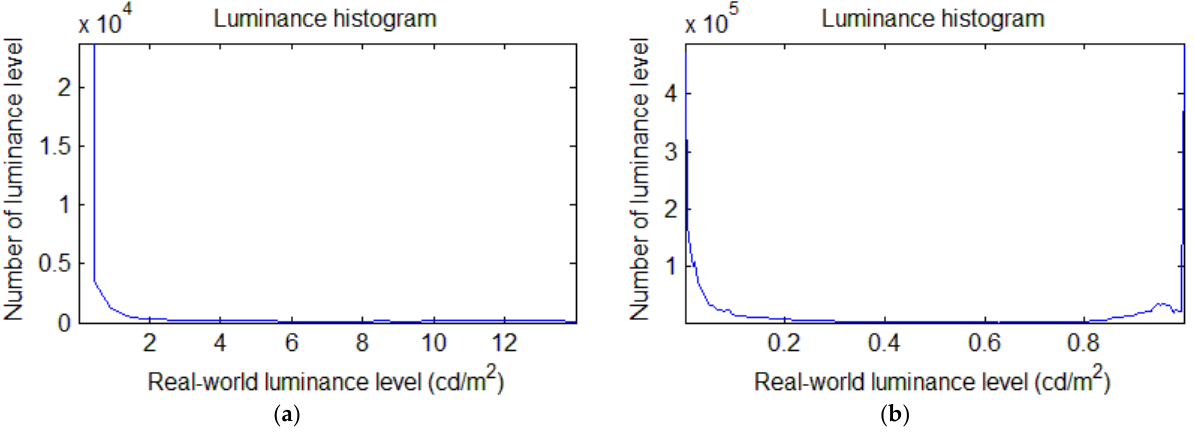
Figure 1. Luminance histogram of memorial church image. ( a ) Memorial Church; ( b ) Moto. It can be seen that most luminance levels distribute at the beginning of the luminance level, and the curve plots a very long and low trailing. This indicates that it is necessary to make the compression for high luminance levels. Meanwhile, a majority of luminance levels, i.e., the low luminance levels, should be stretched to increase the global contrast. Not all of the luminance histograms look like Figure 1a. The luminance levels of some scenes occur in both low ‐ level bins and high ‐ level bins, as shown in Figure 1b. This histo ‐ gram comes from another radiance map called “moto”. Here, we can see that it has equal